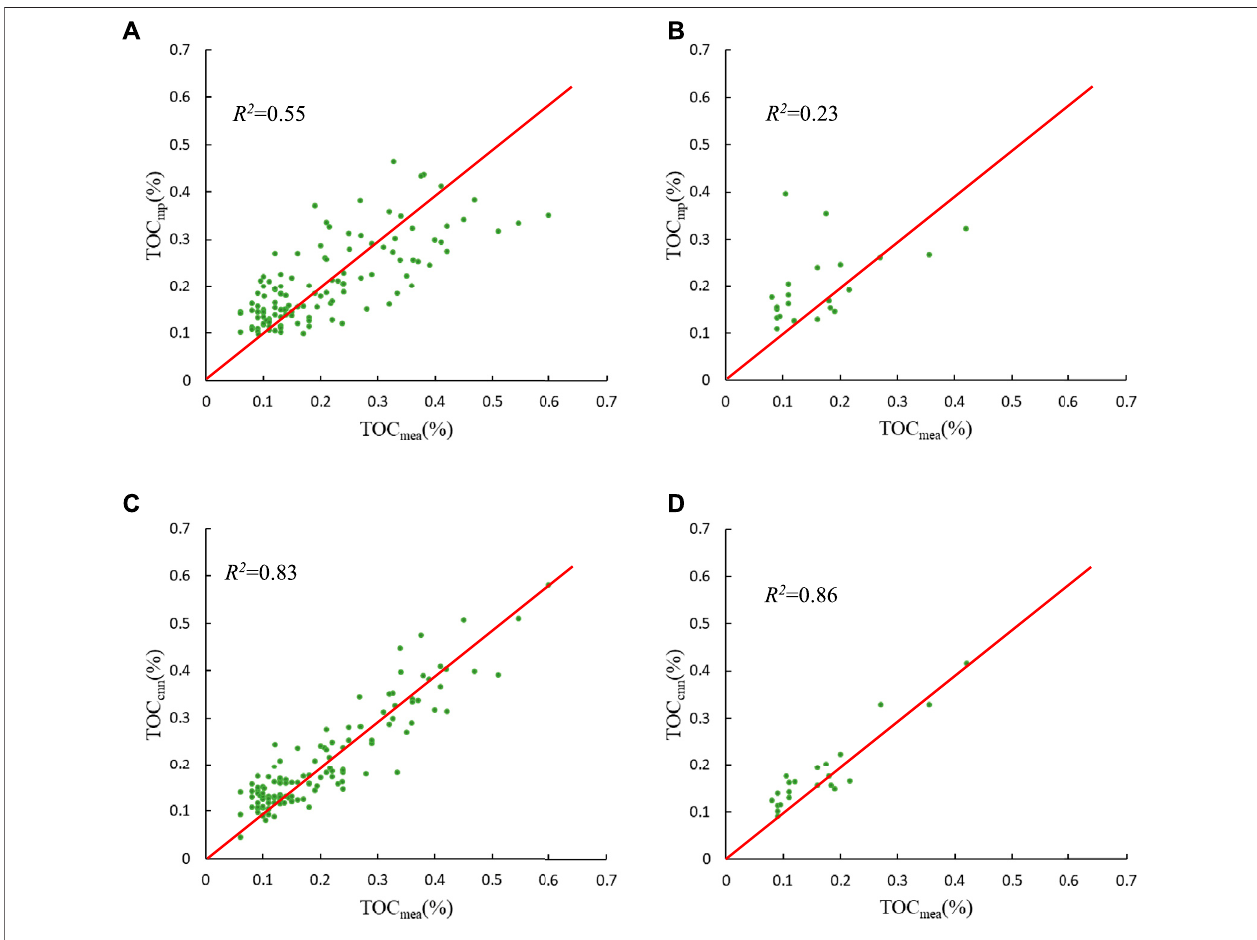
FIGURE 9 | The relationship between measured and calculated TOC content. (A) measured- predicted TOC of training samples with multiple linear regression methods (B) measured- predicted TOC of veri fi cation samples with multiple linear regression methods (C) measured- predicted TOC of training samples with CNN (D) measured- predicted TOCofveri fi cation sampleswithCNN. TOC mea denotes themeasured TOCcontent,andTOC mp and TOC CNN denote thecalculatedTOCcontent using the multiple regression model and the CNN-based model, respectively.